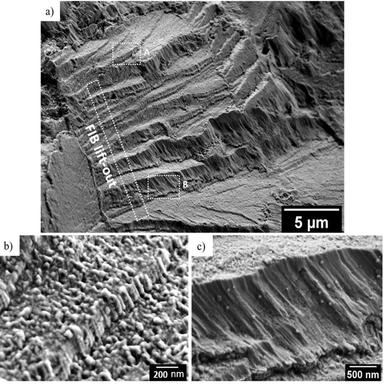
SE images of the fracture surface obtained from a sample tested in pHRT 12.5 and 5000 ppm. (a) classic step-like TG features; (b) oxide that covered the fracture surface (from region A in (a)); (c) possible evidence of plastic shear on one set of facets (from region B in (a)). Note that crack propagation direction is from bottom to top in these images.